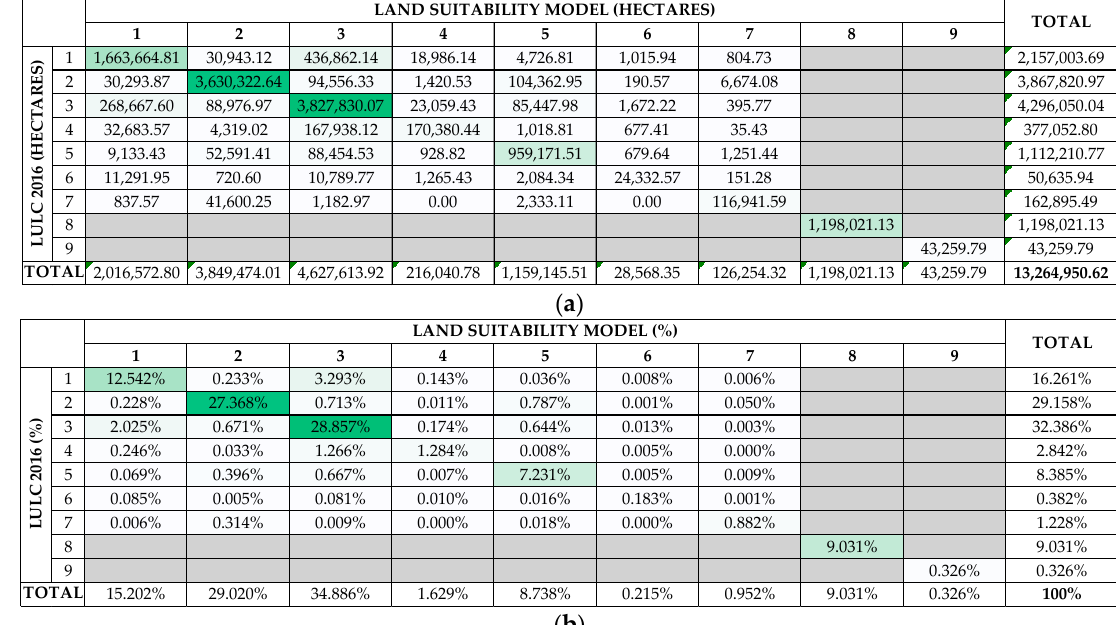
Figure 8. The confusion matrix of the existing land-use/land cover (LULC) and land suitability model: ( a ) land suitability model (hectares) and ( b ) land suitability model (%).